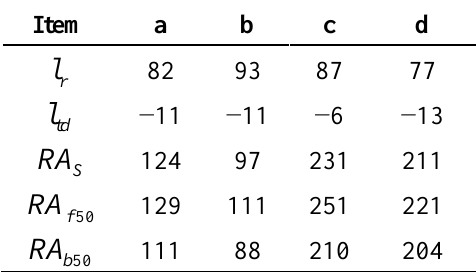
Table 3. The terrain drop measurement results corresponding to